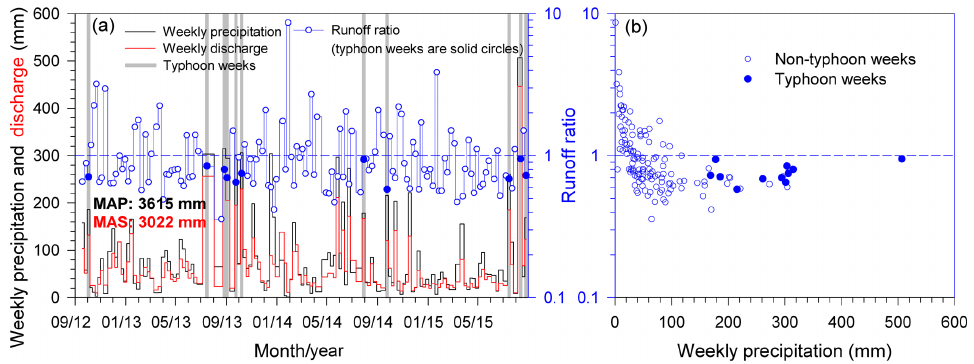
Figure 2. Mean weekly precipitation, discharge and runoff ratio (a) , and the relationship between mean weekly precipitation and mean runoff ratio (b) of the four studied watersheds combined. MAP: mean annual precipitation; MAS: mean annual stream